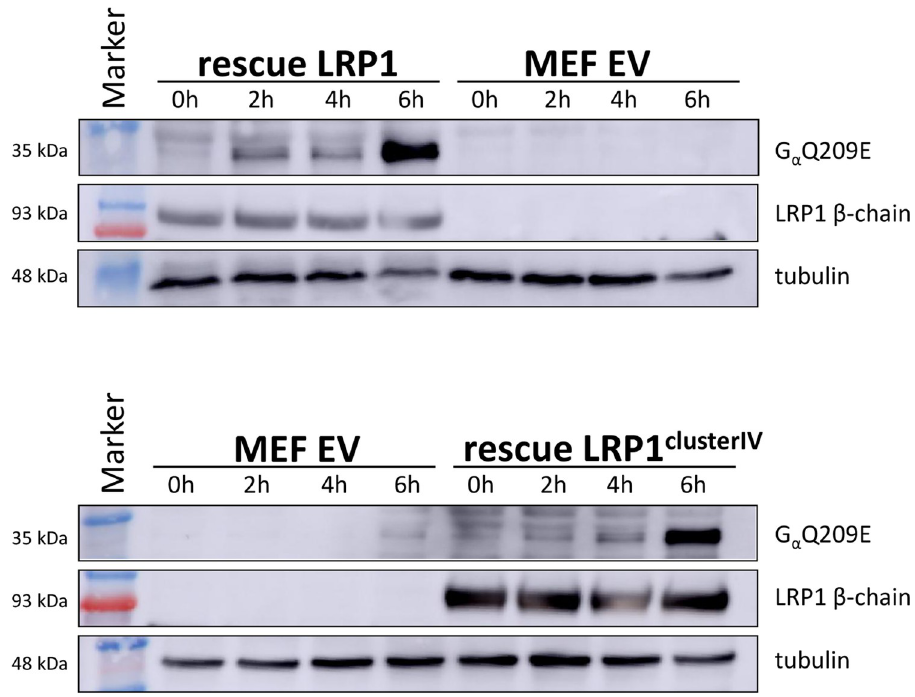
Fig 6. Expression of LRP1 or LRP1 cluster 4 in MEF-LRP1 -/- cells restores the ability of PMT to intoxicate cells. MEF-LRP1 -/- cells were transduced with retroviruses encoding LRP1 (top) or LRP1-cluster 4 (bottom), incubated in the presence of 5 nM PMT for the indicated time intervals, washed and lysed. Lysates were analyzed for toxin-induced modification of G α Q, for expression of LRP1 and for tubulin as loading control.